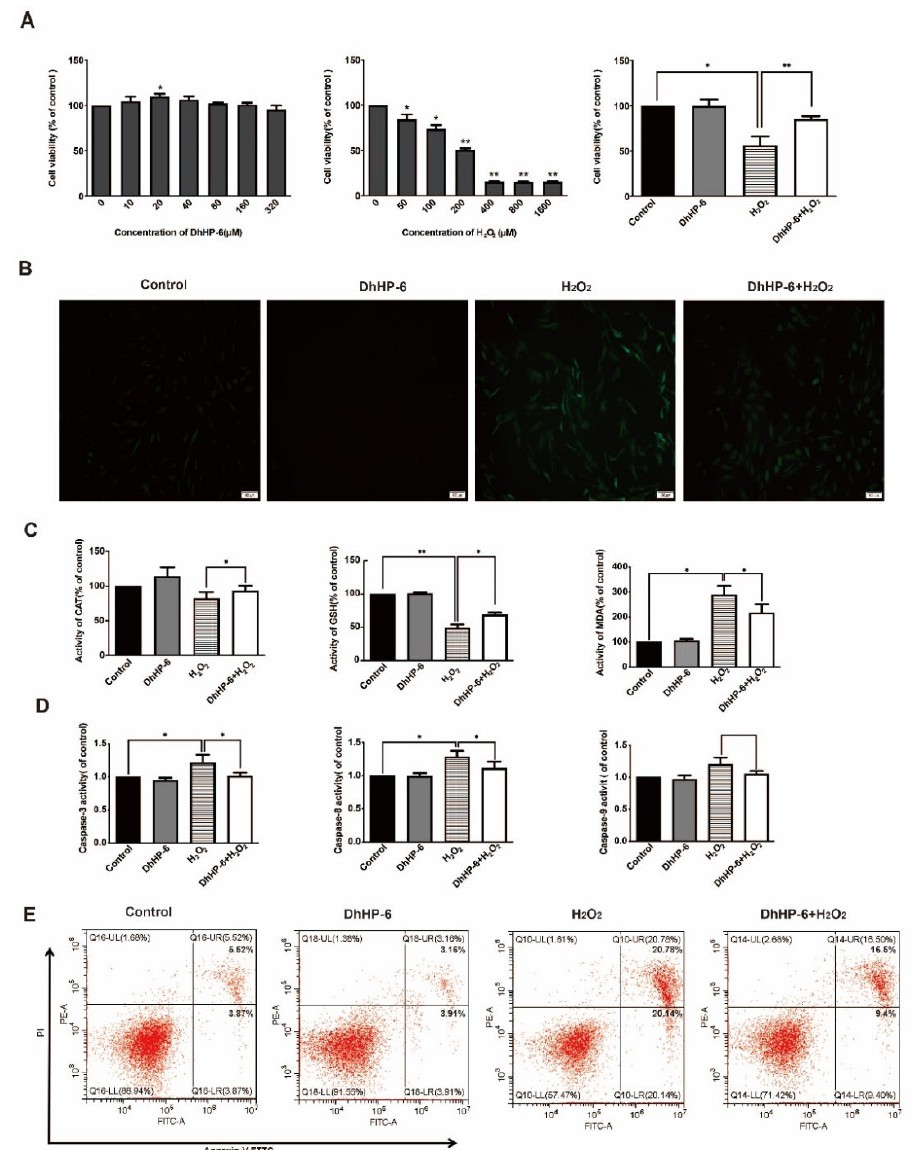
Figure 1. Effects of DhHP-6 on HGFs treated with H 2 O 2 . ( A ) An MTT assay was used to evaluate the proliferation of HGFs treated with DhHP-6 and H 2 O 2 separately and in combination. ( B ) DCFH-DA staining was used to observe ROS levels in HGFs under different treatment conditions. ( C ) ELISA was used to detect the expression levels of CAT, GSH, and MDA in HGFs treated with DhHP-6 and H 2 O 2 . ( D ) The activity of caspase family members in HGFs treated with DhHP-6 and H 2 O 2 . ( E ) Apoptosis was detected by FACS in HGFs treated with DhHP-6 and H 2 O 2 . (* p < 0.05, ** p < 0.01). DCFH staining was used to detect cellular ROS levels [28]. Almost no green fluores- cence was detected in the cells of blank control group and DhHP-6 group. H 2 O 2 group produced a large number of ROS in cells, and the green fluorescence intensity was en- hanced. A small number of ROS were produced in DhHP-6 + H 2 O 2 group, and weak green fluorescence was observed, and the fluorescence intensity was significantly lower than that in the H 2 O 2 group (Figure 1B). The results indicate that DhHP-6 can remove excess and destruction of cells caused by ROS. The levels of CAT and GSH in HGFs treated with DhHP-6 + H 2 O 2 were significantly higher than those in HGFs treated with H 2 O 2 alone. However, the MDA content was significantly reduced, suggesting that DhHP-6